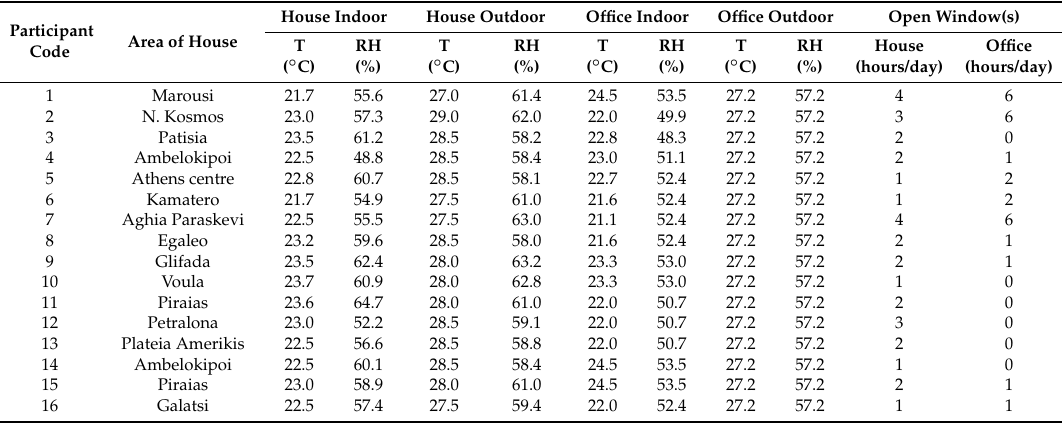
Table 1. Indoor and outdoor average temperature (T) and relative humidity (RH) and average time (hours/day) of at least one open window, recorded for each